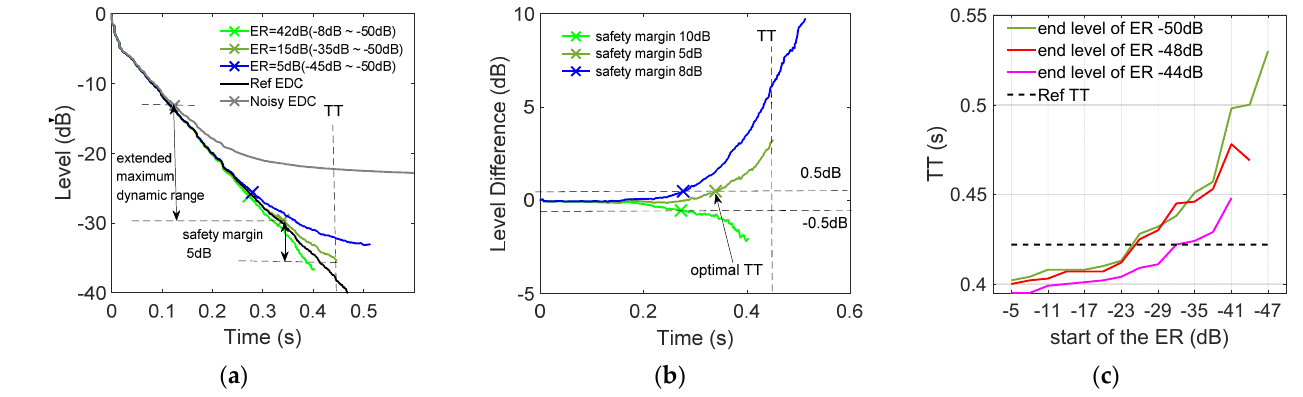
Figure 3. Truncated EDCs and corresponding TT generated from the noise compensation method: ( a ) Reference EDC and the truncated EDCs result from the noise compensation method using different RIR ERs. ( b ) Deviation of the truncated EDC with different ERs given in ( a ) from the reference EDC. ( c ) TT was detected from the noise compensation method by using various RIR ERs.